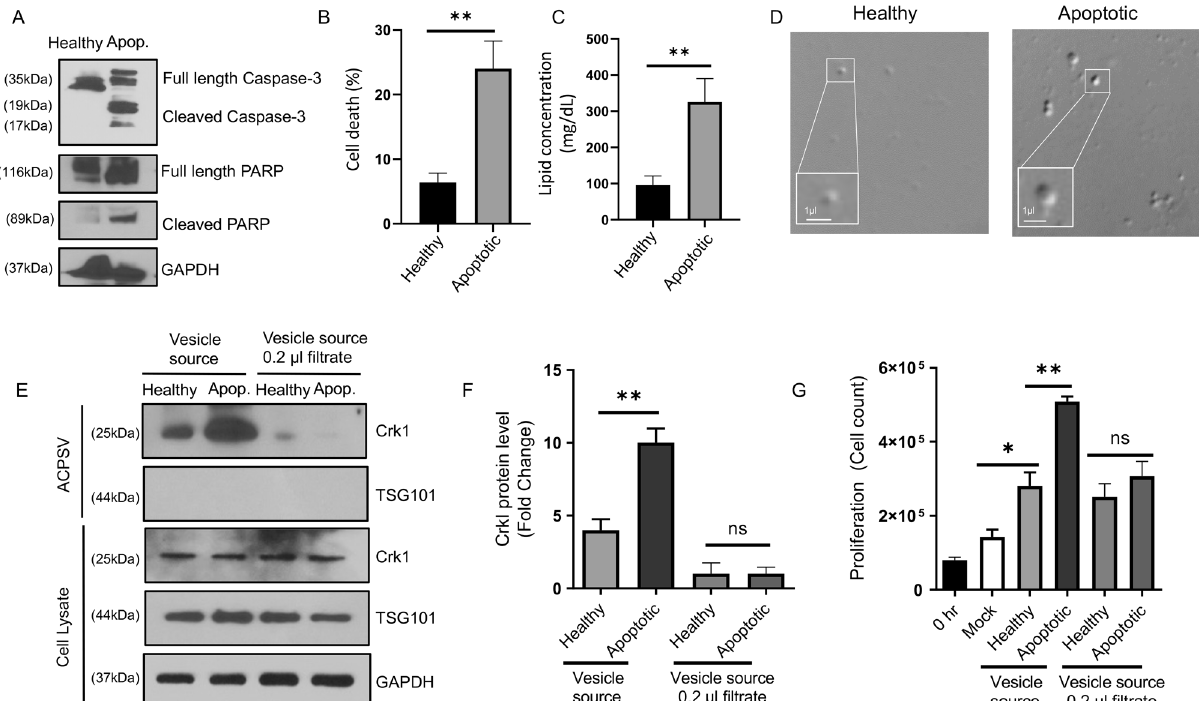
Figure 2. ACPSV production assessment in a metastatic human SCC cancer cell line. (A–G) The human pharyngeal carcinoma metastatic cancer cell line (Detroit 562) was either grown in serum-containing media (Healthy) or serum-deficient media (Apoptotic). (A) Apoptosis was assessed 48 h after serum starvation by Western blotting for apoptosis markers (activated Caspase-3 and PARP). (B) Percent cell death was assessed 48 h after serum starvation. (C,D) ACPSVs were purified from culture supernatant of healthy and apoptotic cells and assessed for their ACPSVs contents by lipid concentration assessment (C) and visualized by DIC imaging (D) . (E,F) The 16K fractions from healthy and apoptotic cell cultures were assessed for their ACPSVs by Western blotting, using ACPSV marker (CrkI) before and after passaging through 0.2-micron filters to remove ACPSVs. The 16K fractions were also probed for their exosome contents, using exosome marker TSG101 to show that these fractions are devoid of exosomes. Representative blot images are shown in (E) and the tabulated data, shown as the mean ± SEM are shown in (F) . (G) The 16K fractions of healthy and apoptotic cell cultures (before and after passaging through 0.2-micron filter) were assessed for their ability to stimulate proliferation in adherent HeLa cells. (N = 3; ns, not significant, *p < 0.01, **p < 0.001. Statistical analyses between groups were performed by One-way ANOVA, and pair-wise comparisons within groups were performed or by unpaired Student’s t (Figs. 1E–G and 2E–G). Interestingly and in contrast to SCC-25 primary cancer cells which only produced ACPSVs under apoptotic conditions (Fig. 1), the Detroit 562 metastatic cancer cells also produced high levels of ACPSVs, capable of inducing proliferation in adherent cells, even under healthy condition (Fig. 2). These data suggest that these Detroit 562 metastatic cancer cells may have uncoupled the ability to produce ACPSVs from the apoptotic cell death signal that is required to initiate ACPSV production in SCC-25 or in HEK or MEK primary cell lines 4 ”. CrkI‑containing ACPSVs are prevalent in SCC tumors.